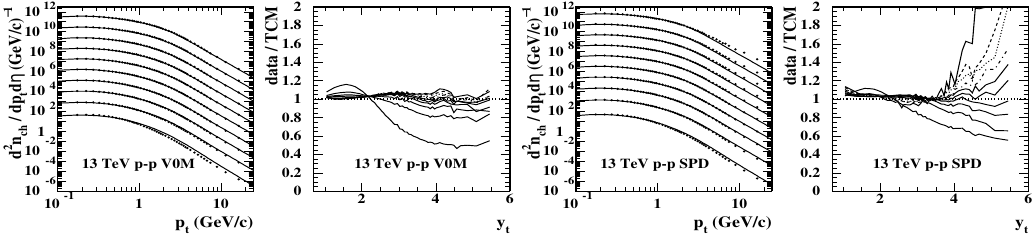
Figure 1: Published p spectra (points) and TCM (solid) for 13 TeV p - p collisions and t for V0M (left) and SPD (right) event selection together with data / TCM data-model